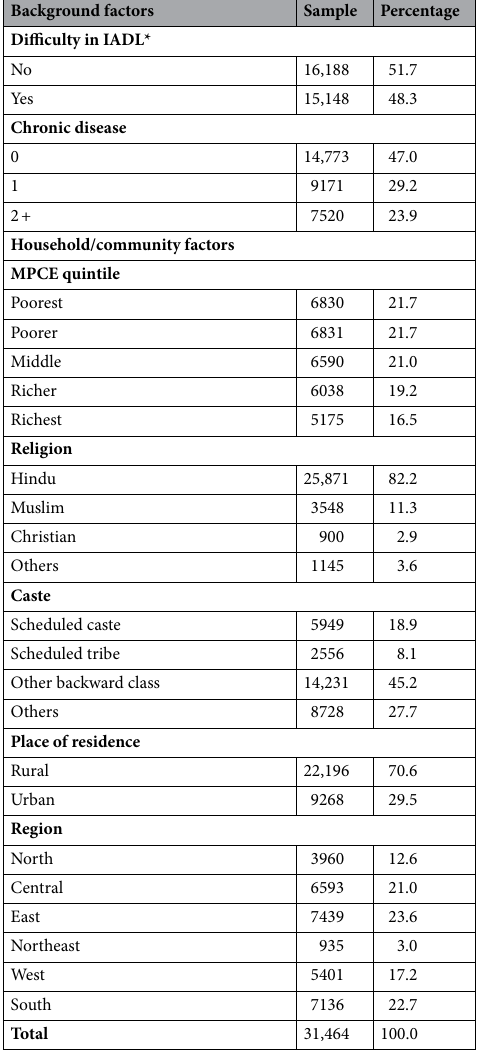
Table 1. Socio-economic profile of older adults in India, (n = 31,464). *Sample size may differ due to missing cases; MPCE, Monthly per capita consumption expenditure; ADL, Activities of daily living; IADL, Instrumental activities of daily living; Percentages are